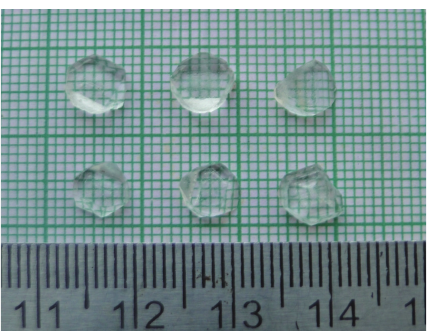
Figure 1: As-grown single crystals of MHT.